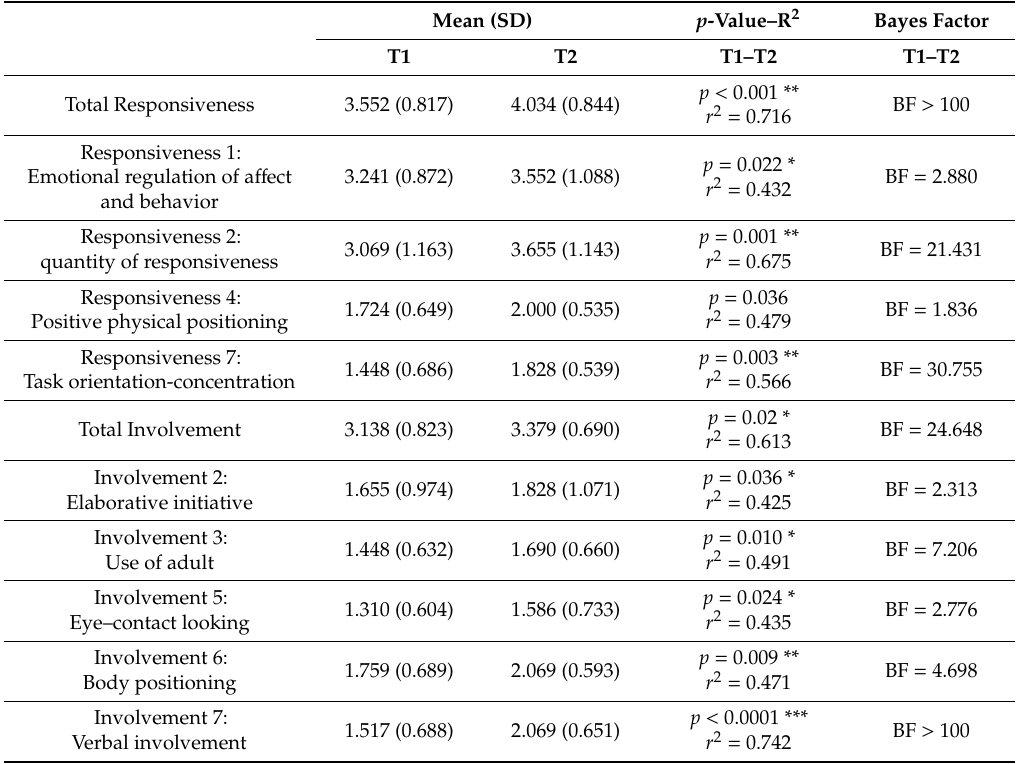
Table 5. Descriptive and Inferential Statistics of the Child Emotional Availability Scales–Main Scales